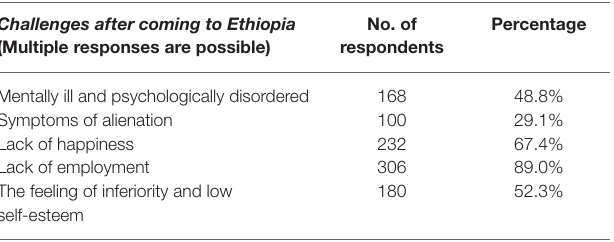
TABLE 5 | Contribution by the government and NGOs. Contributes given to return migrants (Multiple responses are